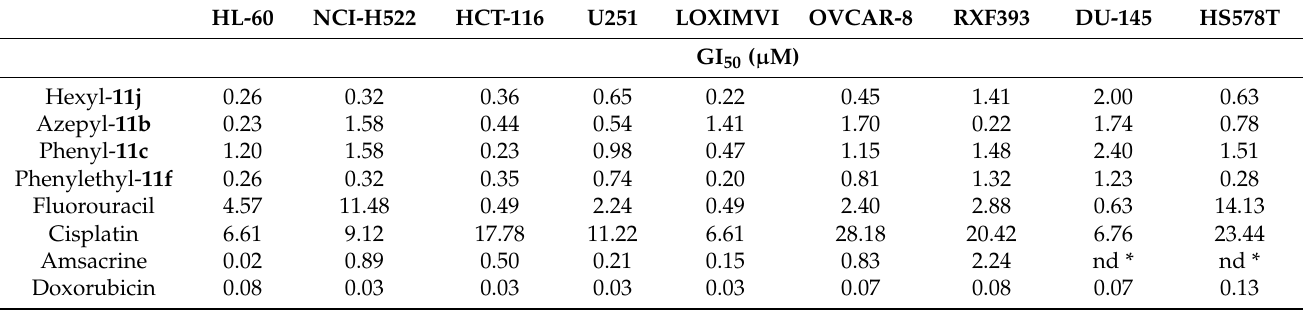
Table 3. Growth inhibition concentration (GI 50 ) of ureas 11b , 11c , 11f and 11j , fluorouracil, cisplatin, amsacrine and doxorubicin against various human cancer cell lines. GI 50 values are given as a micromolar